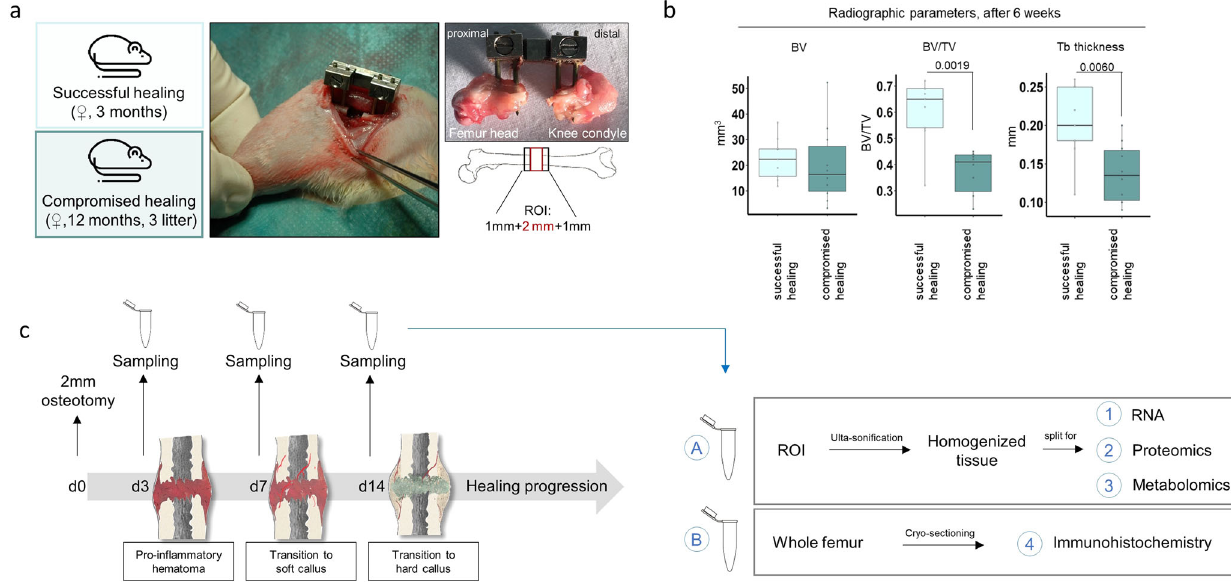
Fig. 1 Schematic overview of applied in vivo fracture healing model and experimental work fl ow. a Applied surgical procedure introducing a 2 mm standardized osteotomy gap in the left femur of young rats, aged 3 months, showing normal bone healing are compared to aged rats (12 months) that had a minimum litter of three, showing biologically compromised bone healing. b Newly formed bone has different properties in successful healing compared to compromised healing. Successful healing showed higher bone volume ratio and trabecular thickness, while bone volume did not change in comparison to compromised healing after 6 weeks. n = 9 – 10 individual biological replicates, Mann-Whitney U test 19,21,22 Central image: external fi xator placed on the left femur, right image: dissected femur, where the region of interest (ROI: 2 mm hematoma + 1 mm proximal and distal to fracture gap) has been removed. All bones were placed in the same orientation for histological analysis, with the femur head (proximal) on the left side and the knee condyle (distal) on the right side of the image. BV - bone volume, TV- total volume, Tb – trabecular. Rat icon obtained from: Flaticon.com, artist: Nhor Phai. c Samples were harvested at day 3, 7 and 14 after osteotomy and subjected to the different downstream analysis, ROI – region of